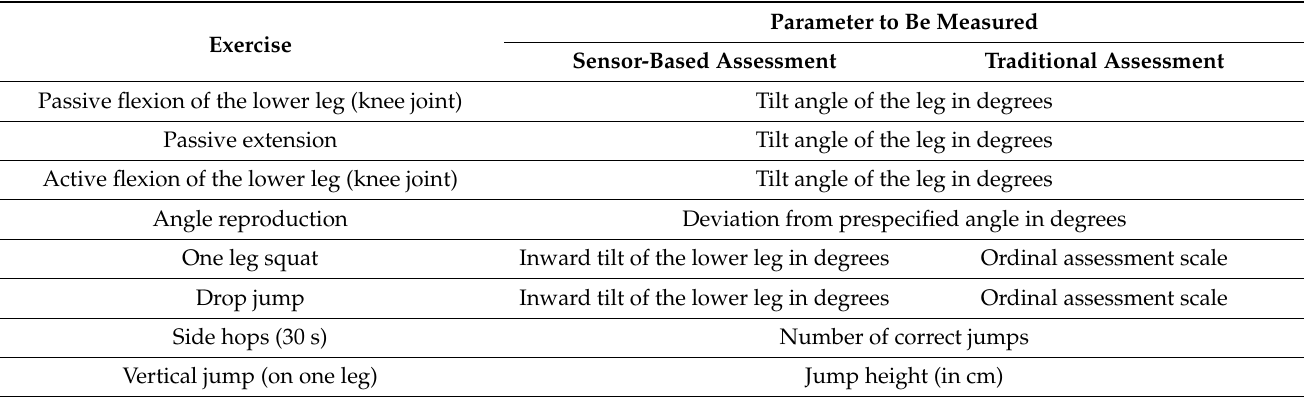
Table 2. Parameters assessed for the eight exercises